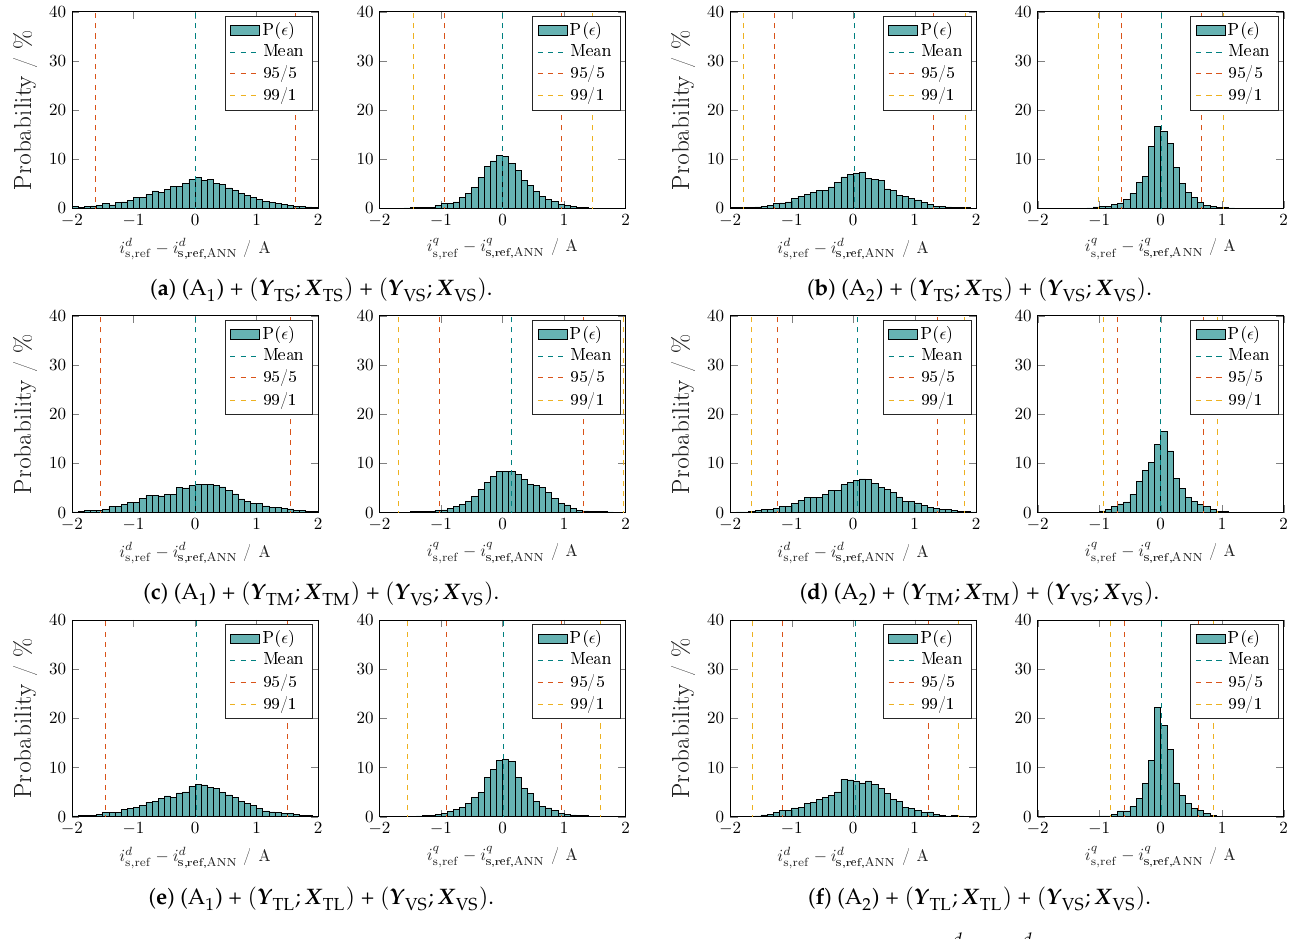
Figure 17. Illustration of individual error distributions ε = i d ε = i q [right subplots] obtained during the validation of the ANN Architectures (A 1 ) i q s,ref,ANN s,ref − [left column, i.e., ( a , c , e )] & (A 2 ) [right column, i.e., ( b , d , f )] with the small, medium and large validation data sets ( Y VS ; X VS ) ( Y VM ; X VM ) and ( Y VL ; X VL ) ,